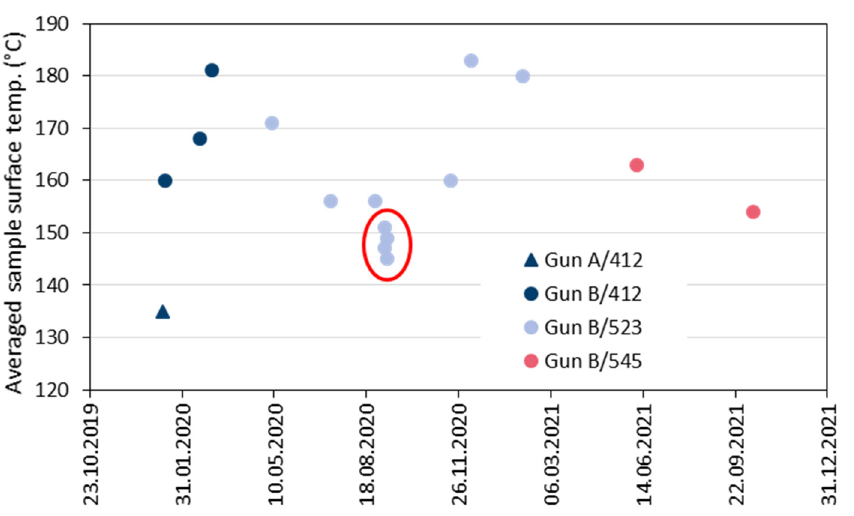
Figure 10. Variability of the averaged sample surface temperature evaluated in the period of 2020 and 2021; the legend indicates the gun in use and the designation of the powder batch.